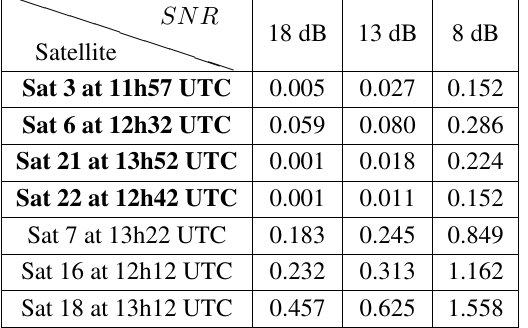
Table 2. RMSE of the estimated height ˆ h , in meters, for an observation interval of 300 s. Reference height h = 2 m and α